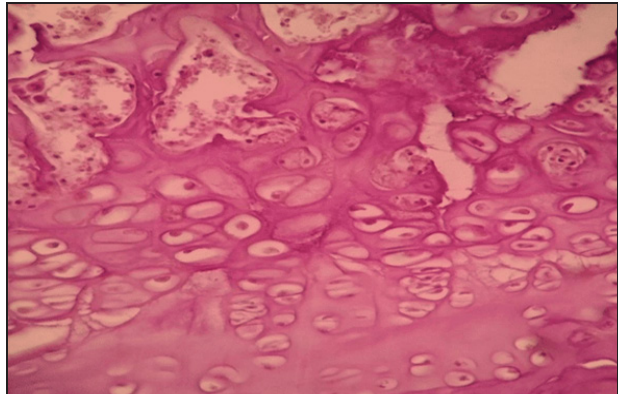
Figure-IV: Photomicrograph of distal tibia of a rat